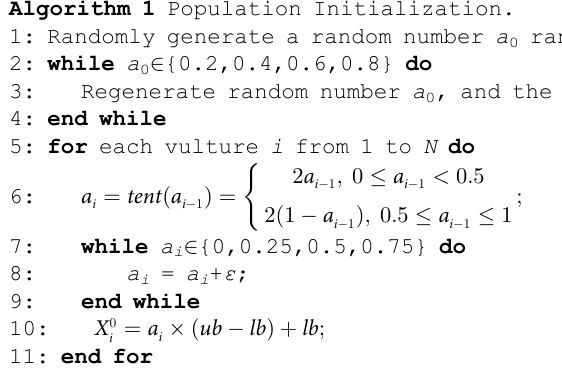
Algorithm 1 Population